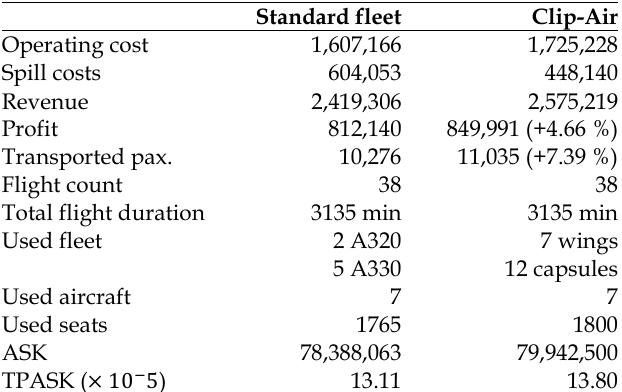
Table 5. Results for the airport-pair network